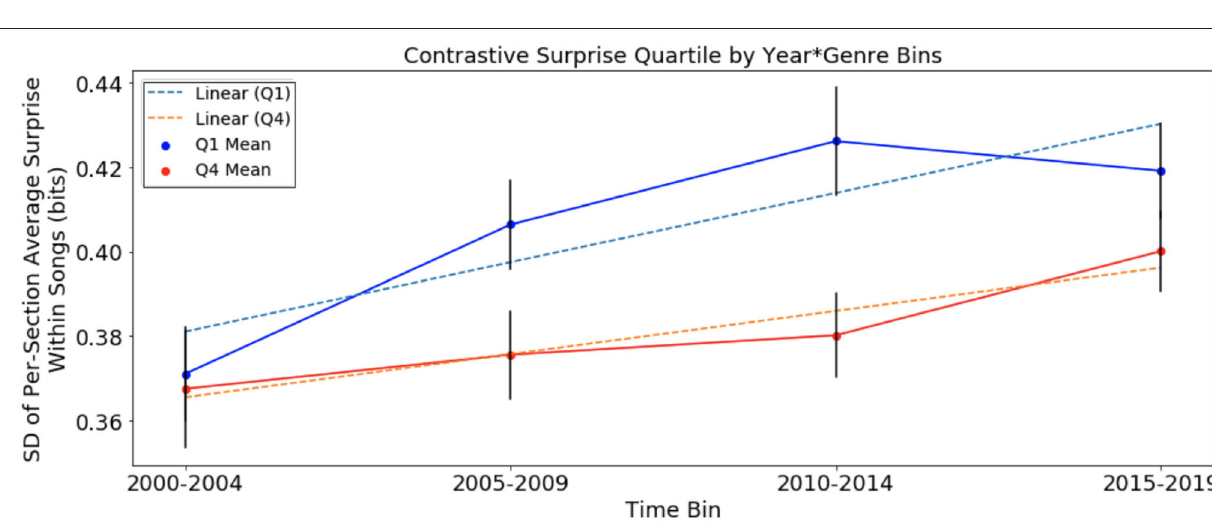
FIGURE 4 | Variation of harmonic surprise across sections of songs, with harmonic surprise calculated using chord distribution of January 2000 to December 2004, of Q 1 and Q 4 , separated into time bins. Error bars represent standard error. Variation of surprise across sections rises faster in Q 1 than in Q 4